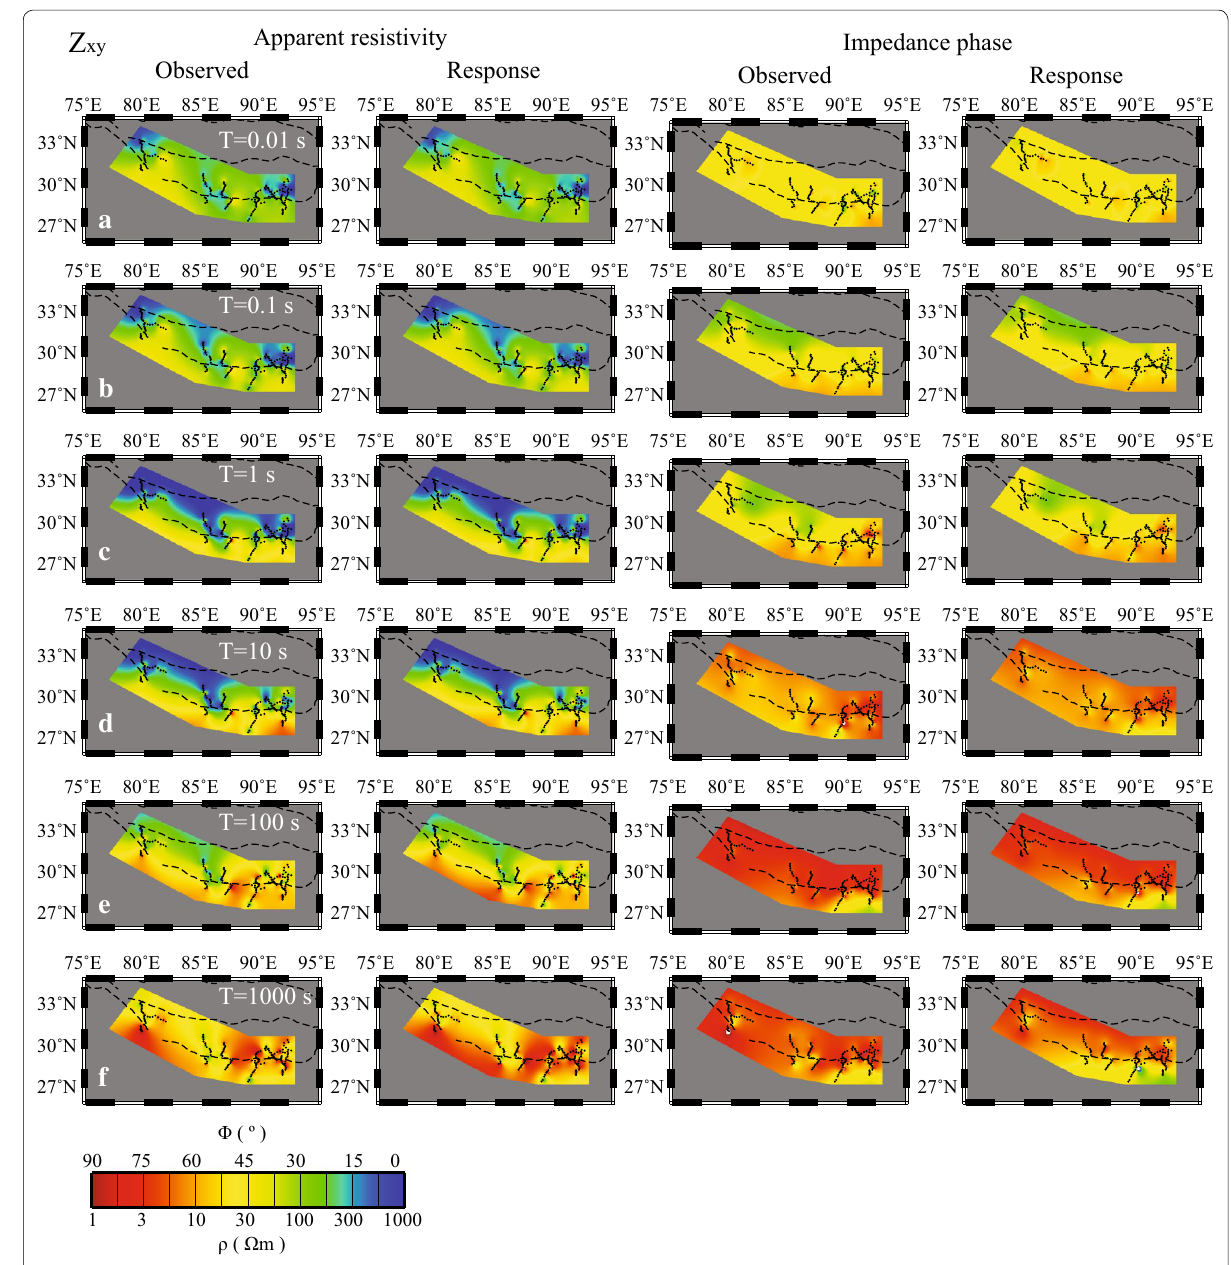
Fig. 4 Measured apparent resistivity and impedance phase and 3D model response in the horizontal pseudo-slice format at different periods for Z xy . T 0.01 s ( a ), 0.1 s ( b ), 1 s ( c ), 10 s ( d ), 100 s ( e ), and 1000 s ( f =